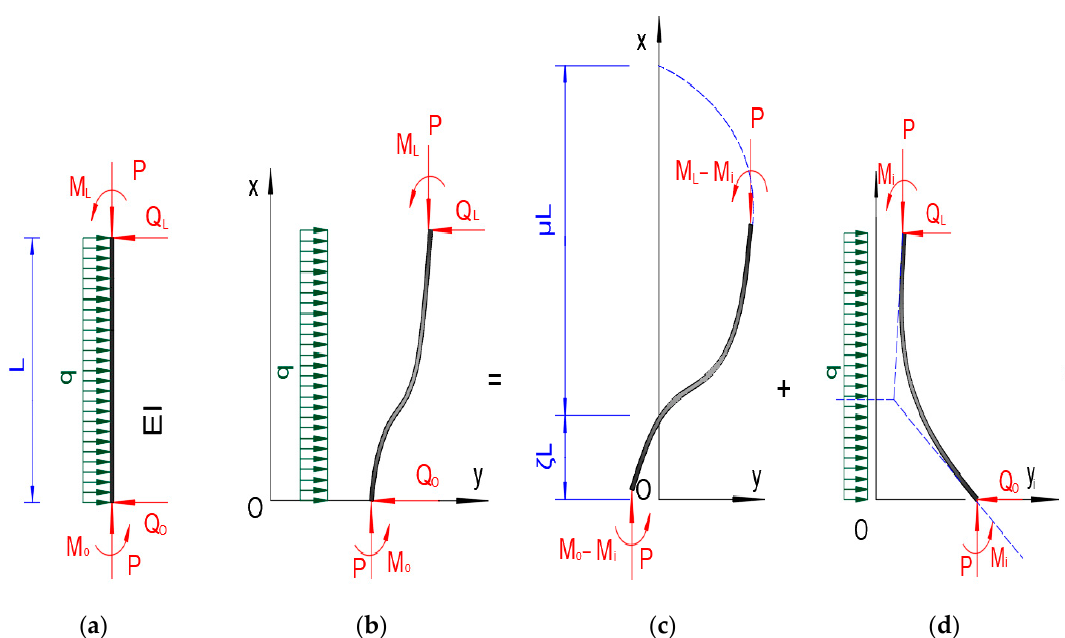
Figure 3. Schematic diagram of force superposition principle of the compression rod: ( a ) the force diagram of the compression rod; ( b ) diagram of the compression rod in a curved equilibrium state; ( c ) the sine curve decomposed by the deflection function; and ( d ) the quadratic parabola decomposed by the deflection function.